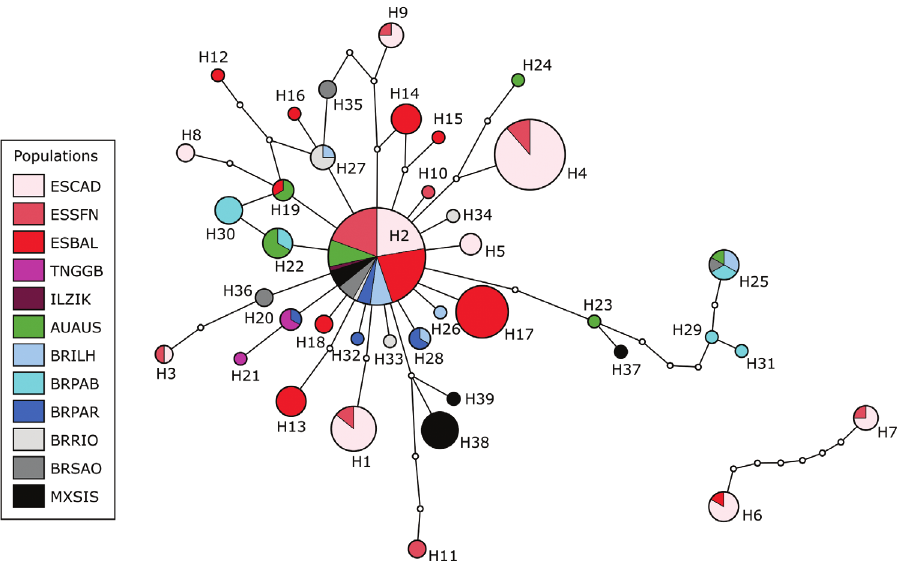
Figure 1. Mitochondrial (COI+16S) haplotype network of Paracaprella pusilla from its presumed na- tive and non-native range. Haplotypes 6 and 7, corresponding with 10 individuals of Cadiz (ESCAD and ESSFN) and Baleares (ESBAL) populations, were grouped in an independent network. This net- work could not be connected using the 95% parsimony connection limit to the main haplotype network which includes most of the haplotypes found in P. pusilla . Haplotype circles are proportional to haplotype frequency and numbers represent haplotype identities (Table 3). Non-observed haplotypes (extinct or unsampled haplotypes) are represented by small white circles. Each line connecting haplotypes represents a single mutational